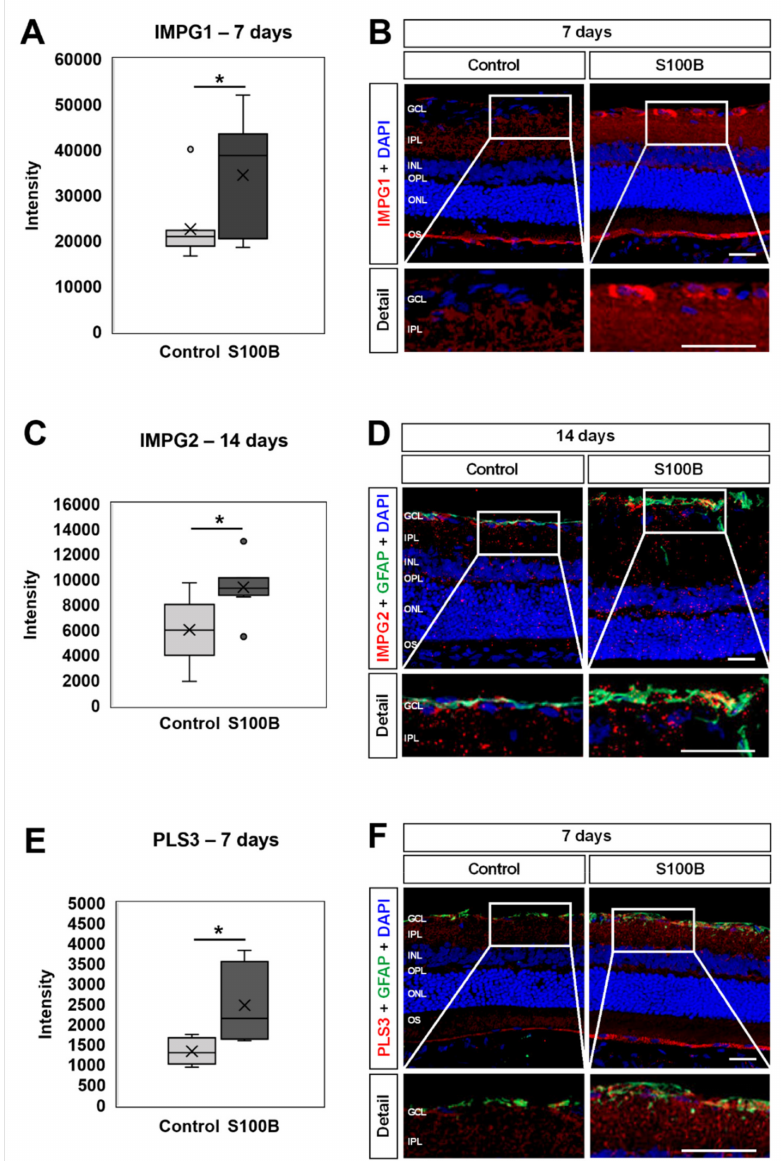
Figure 9. Up-regulated expression of various matrix proteins. ( A ) Mass spectrometry revealed an up-regulation of IMPG1 in S100B rats 7 days after immunization ( p = 0.042). ( B ) Representative